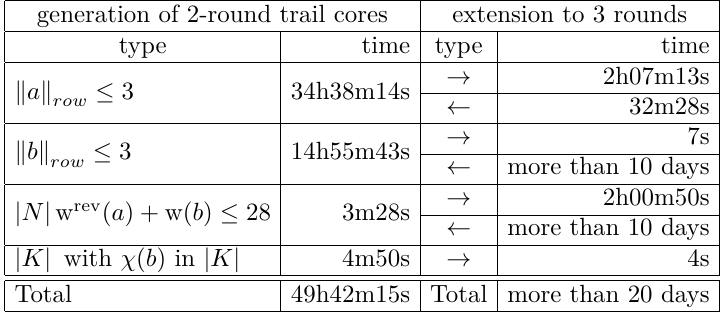
Table 10: Execution time for the generation of 3-round trail cores up to weight 36 using the techniques of [DV12] and the KeccakTools .